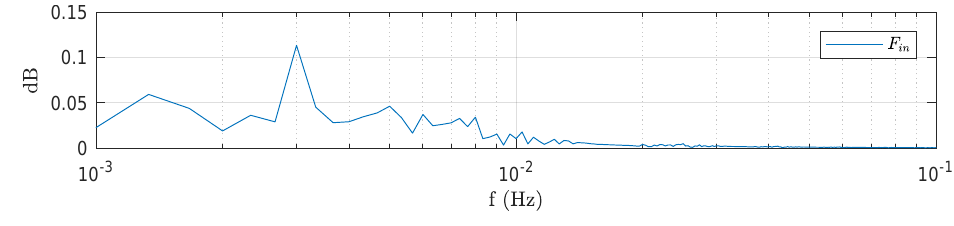
Figure 7. Frequency spectrum of the input signal F in . Table 4. Experimental scenarios, the occurrence of the scenarios are marked with dotted vertical lines in the simulation plots.